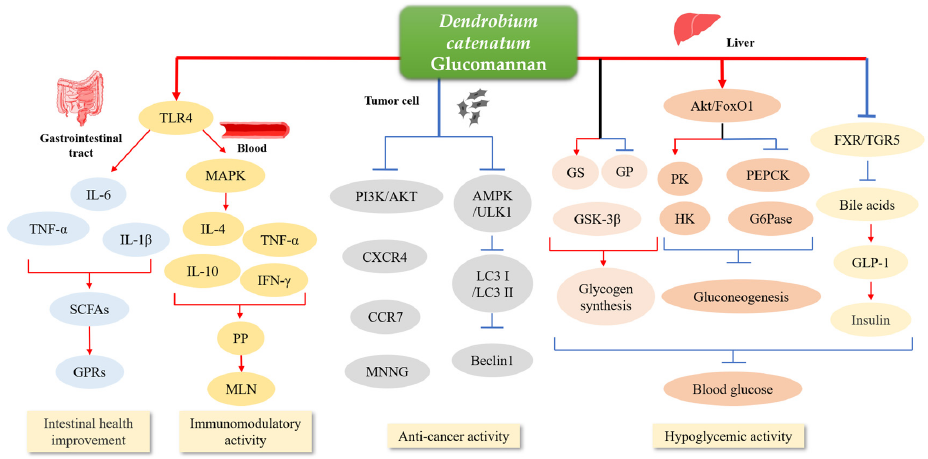
Figure 3. The effects of glucomannan from D. catenatum stem. DOP, Dendrobium officinale polysac- charide; TLR4, toll-like receptor4; IL-4, Interleukin-4; IL-6, Interleukin-6; IL-10, Interleukin-10; IL- 1 β , Interleukin-1 β ; TNF, tumor necrosis factor; PI3K/AKT, phosphatidylinositol 3 kinase/protein ki- nase B ; CXCR4, chemokine receptor4; CCR7, CC chemokine receptor 7; AMPK, adenosine monophosphate-activated protein kinase; ULK-1, UNC-51 like autophagy acti- vating kinase 1; LC3, light chain 3; SCFAs, short-chain fatty acids; GPRs, g-protein-coupled recep- tors; MAPK, mitogen-activated protein kinase; PP, Peyer’s patche; MLN, mesenteric lymph node; MNNG, 1-methyl-2-nitro-1-nitroguanidine; GS, glycogen synthase; GP, glycogen phosphorylase; GSK-3 β , glycogen synthase kinase 3 β ; PK, pyruvate kinase; HK, hexokinase; PEPCK, phosphoe- nolpyruvate carboxykinase; G6Pase, glucose-6-phosphatase; GLP-1, glucagon-like peptide-1. 3.1.1. Intestinal Health Improvement It has been reported that glucomannan can modulate mouse cecal and fecal microbi- ota with favorable prebiotic effects [38]. The unique properties of glucomannan hydroly- sate make it valuable as a prebiotic in a wide range of food, feed, and pharmaceutical products [39]. Prebiotics promote specific changes in the gastrointestinal microbiota [40], promote the growth of probiotics such as Lactobacillus and Bifidobacterium, inhibit the proliferation of harmful bacteria, reduce inflammation, improve the integrity of the intes- tinal mucosa, promote nutrient absorption [41], and control the blood glucose level of pa- tients with type 2 diabetes [42]. Glucomannan selectively stimulates the production of beneficial gut microflora such as probiotics and benefits the treatment of functional